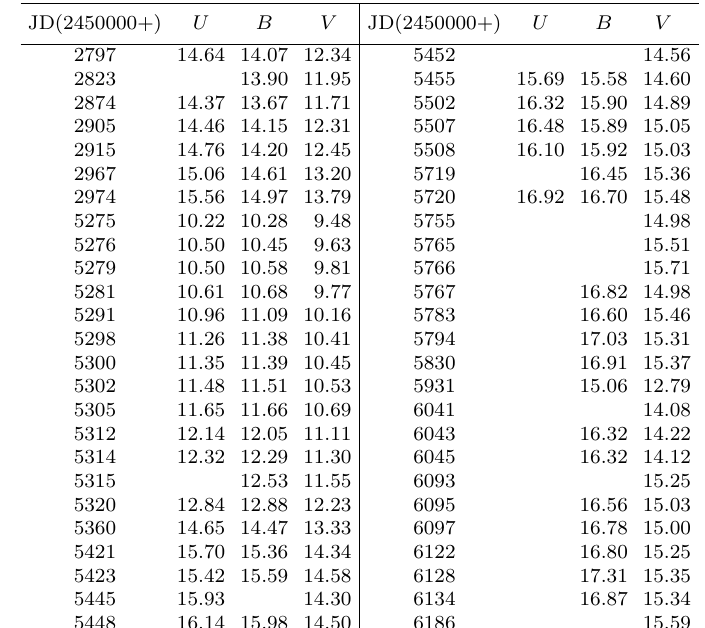
Fig. 2. Rapid brightness variations of V407 Cyg (open circles) after its RS Oph-type outburst (left panel, 2014.07.22) and before it (right panel, 2002.06.20, Kolotilov et al. 2003). Crosses denote the measurements of the comparison stars. Table 1. UBV photometry of V407